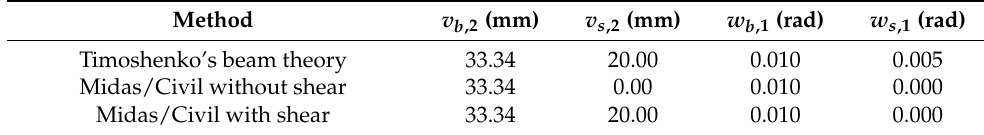
Table 2. Properties of the FEM of the simply supported